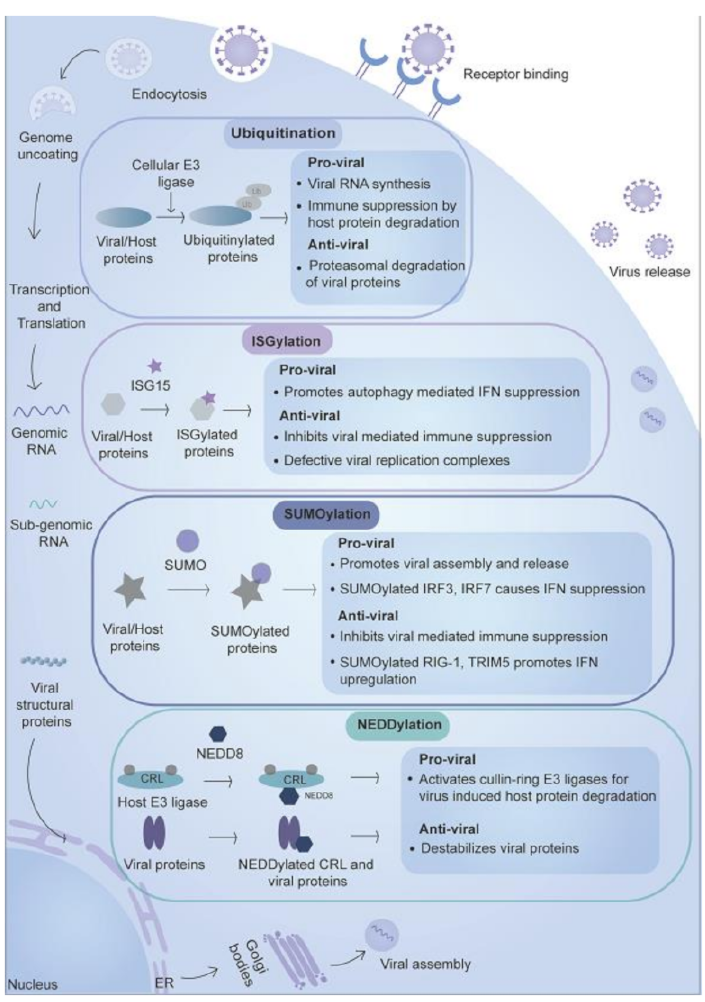
Figure 2. Small protein-based post-translational modifications during viral infection. Ubiquitin and ubiquitin-like molecules such as ISG15, NEDD8, and SUMO play an essential role during viral infection. Specific enzymes such as E1, E2, and E3 ligases are involved in the modification process. The anti-viral effect is exerted by inducing IFN response, destabilizing viral proteins, or targeting viral proteins to their degradation. These modifications also exert a pro-viral impact by improving the enzymatic activity or interactions of the viral proteins, which promotes viral replication and degradation of host proteins involved in immune response